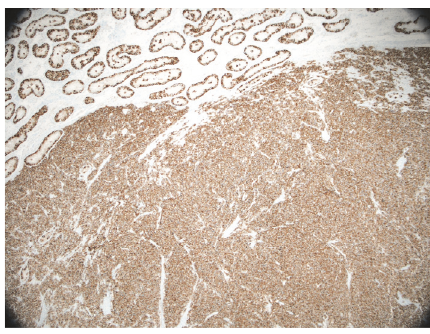
Figure 6: Testicular seminoma (PLAP IHC stain, magnification × 40).